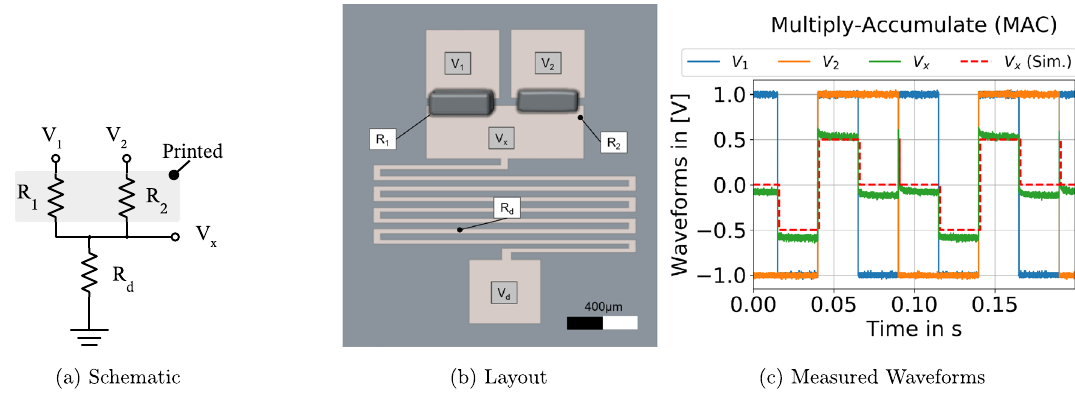
Figure 2. ( a ) The schematic of the 2-input crossbar ( V 1 , V 2 ) implementing the MAC operation. ( b ) Depicts the layout of the fabricated MAC circuit. ( c ) Illustrates the waveforms from the simulation and circuit